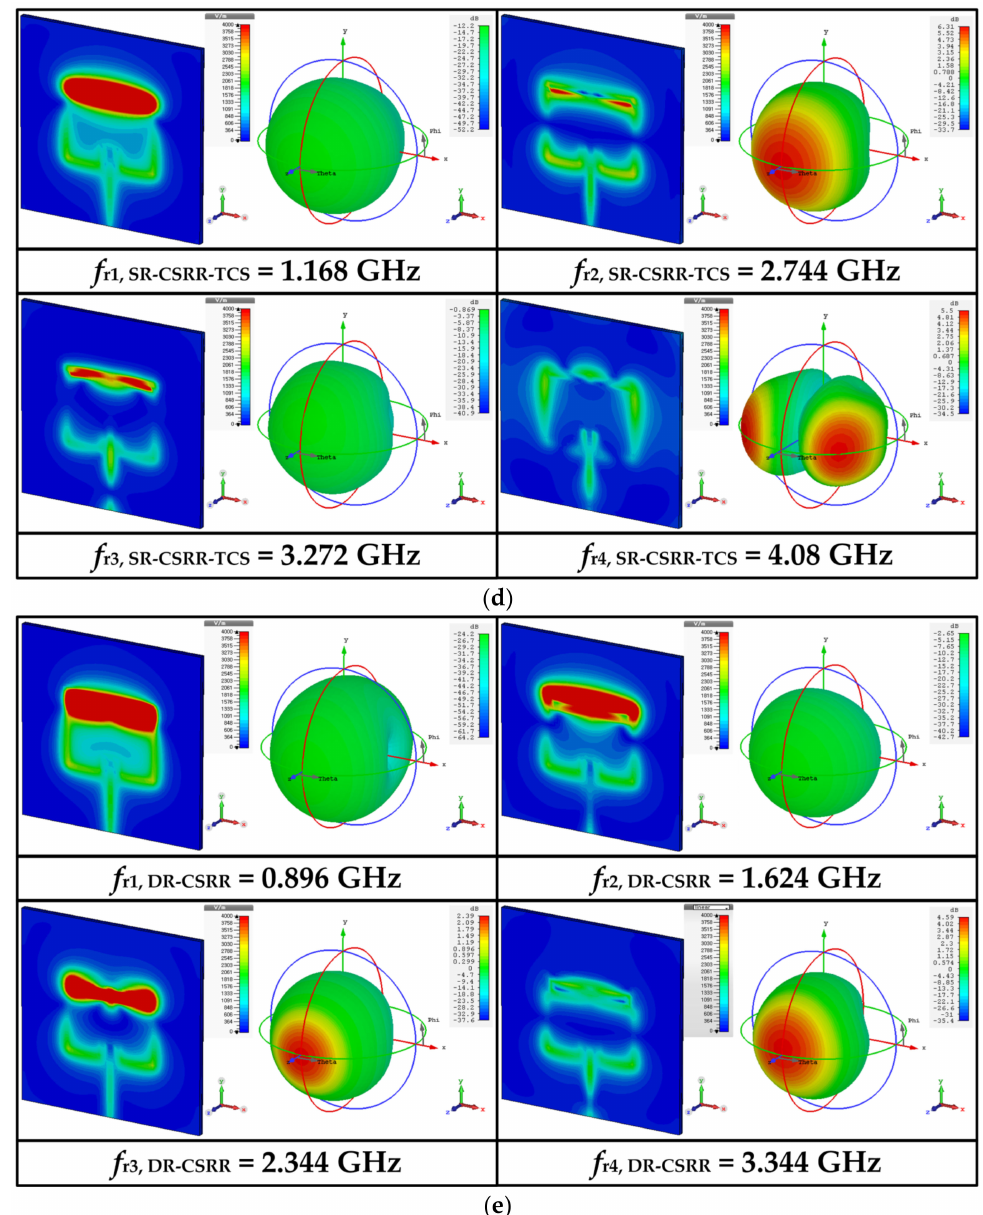
Figure 3. Simulated electric field distributions and radiation patterns of the reference rectangular and four slot-loaded MPAs at the first six resonant frequencies: ( a ) reference rectangular MPA, ( b ) RS-loaded MPA, ( c ) SR-CSRR-BCS slot-loaded MPA, ( d ) SR-CSRR-TCS slot-loaded MPA, and ( e ) DR-CSRR slot-loaded MPA. The calculated resonant frequencies appeared at f TM010 = 2.5 GHz, f TM200 = 4.081 GHz, f TM210 = 4.785 GHz, f TM020 = 5.0 GHz, f TM220 = 6.45 GHz, and f TM030 = 7.5 GHz. Although the order and values of the resonant frequencies for the TM 210 and TM 020 modes were changed, the simulated resonant frequencies agree well with the theoretical resonant frequencies of the patch cavity. In addition, the mode number in the resonance mode equals the number of nulls in the electric field distribution in each